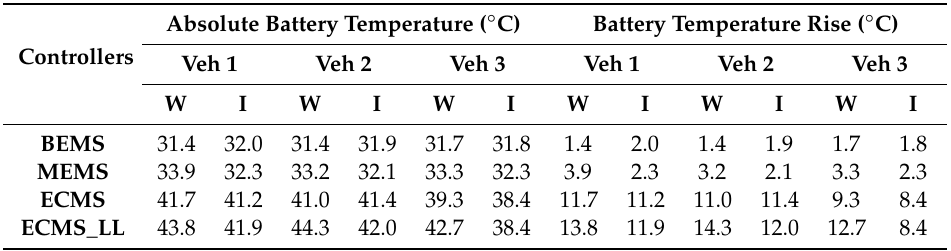
Table 6. Battery temperature and battery temperature rise for di ff erent vehicle configurations tested for WMTC (W) and IDC (I) test